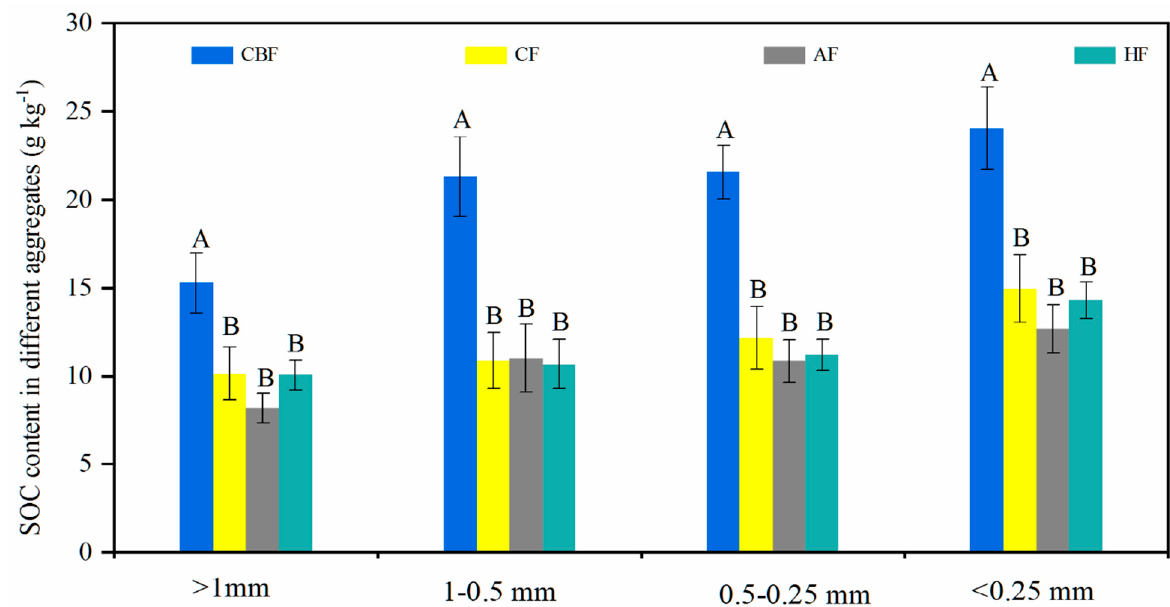
Figure 2. SOC for each aggregate fraction of the different forest types. Note: The different capital letters indicate significant differences in the same aggregate size among different forest types ( p < 0.05). Values are means ± standard errors. Table 4. Correlation between 137 Cs and organic carbon content of aggregates.